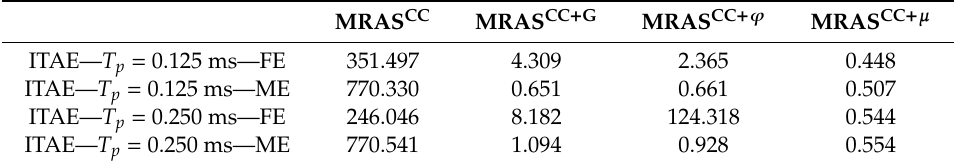
Table 3. ITAE criterion values for slow speed reversal of Figure